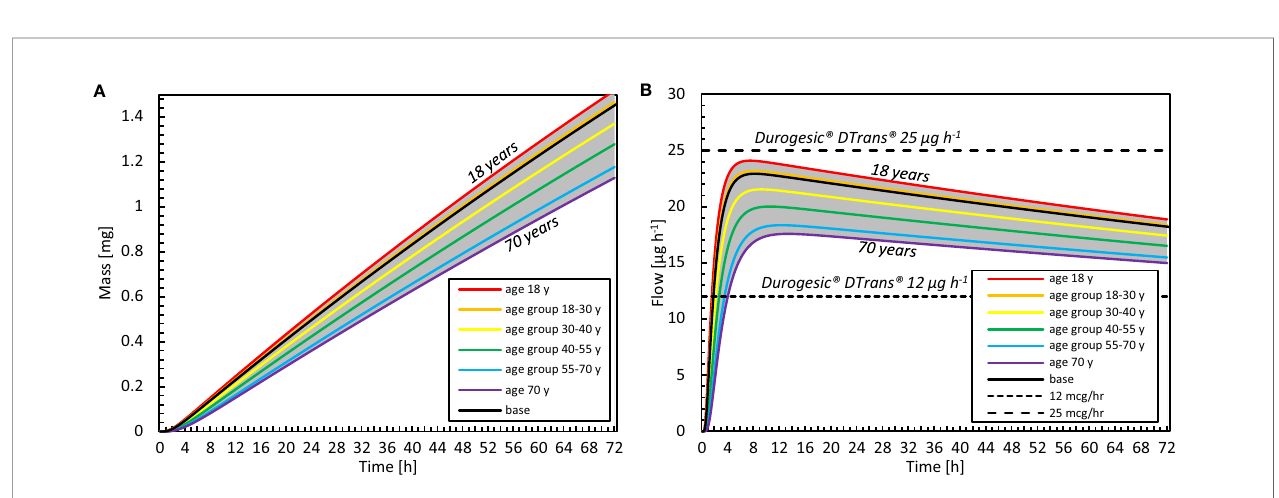
FIGURE 12 | (A) Cumulative amount of drug taken up in the blood as a function of time for different age categories. The results of the average age of each group are shown, as well as the minimal and maximal ages. (B) Drug fl ow taken up by the blood as a function of time for different age groups and commercial fentanyl patches. For both A, B the gray band indicates the entire range of ages that is evaluated (18 – 70 years).